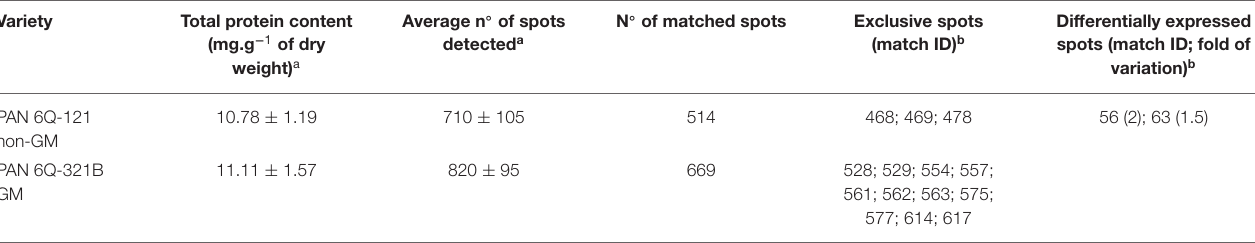
TABLE 1 | Total protein content, detected spots and matched spots of PAN 6Q-121 non-GM and PAN 6Q-321B GM maize varieties grown under farm conditions in Bloemfontein, South-Africa. Variety